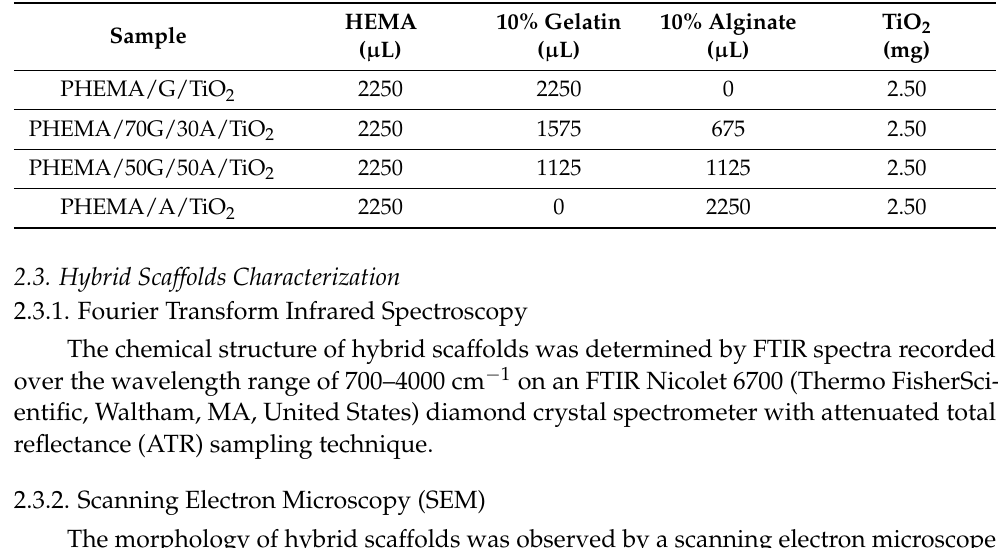
Table 1. Composition and labels of